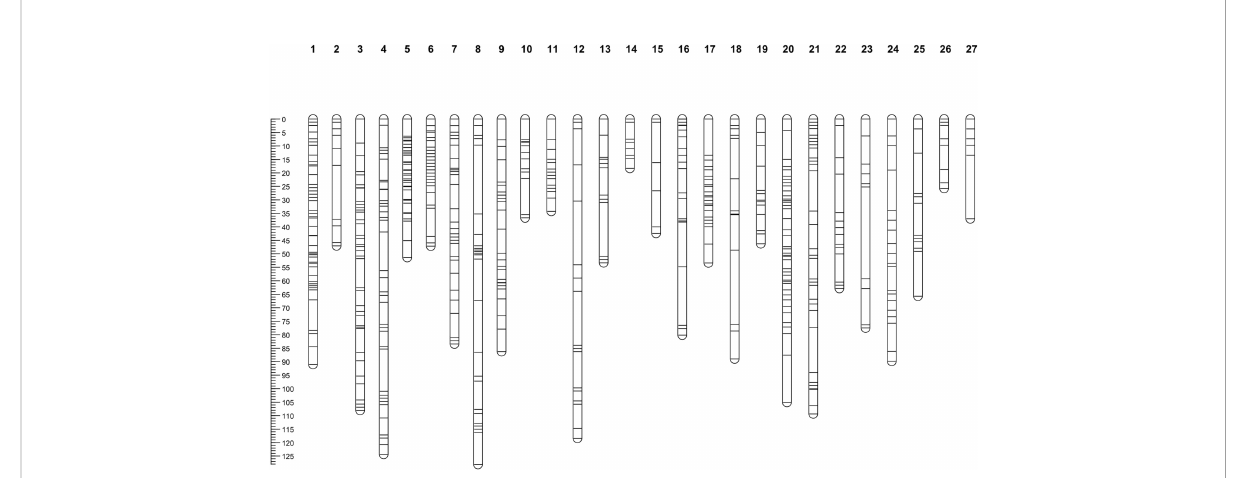
FIGURE 2 Linkage map of Gerbera hybrida containing 27 linkage groups developed by using SNPs discovered from genotyping by sequencing. The mapping F 1 population consisted of 88 individuals developed by crossing two breeding lines UFGE 4033 and 06-245-03. The scale plate on the left displays genetic distance in centiMorgan (cM) that was calculated using the Kosambi mapping